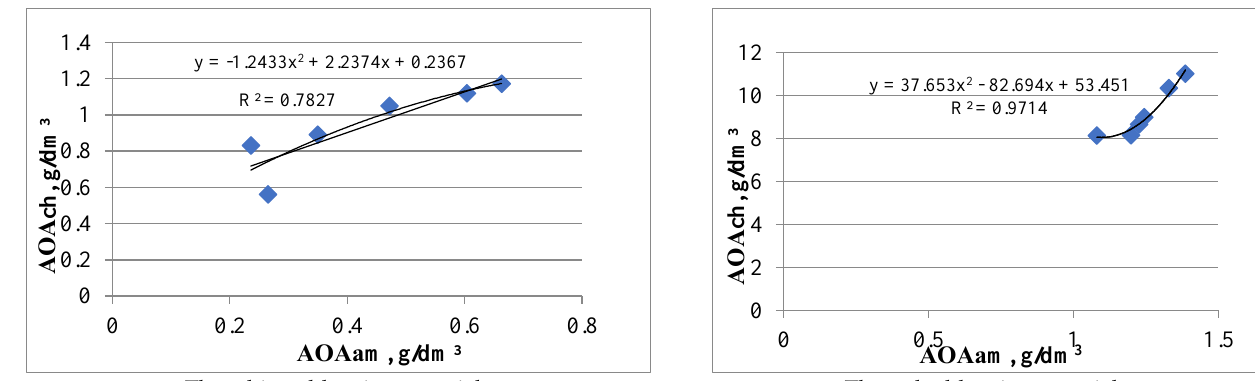
Figure 1. Correlation of amperometric and chemiluminescent methods to determine the AOA of white and red table wine materials.